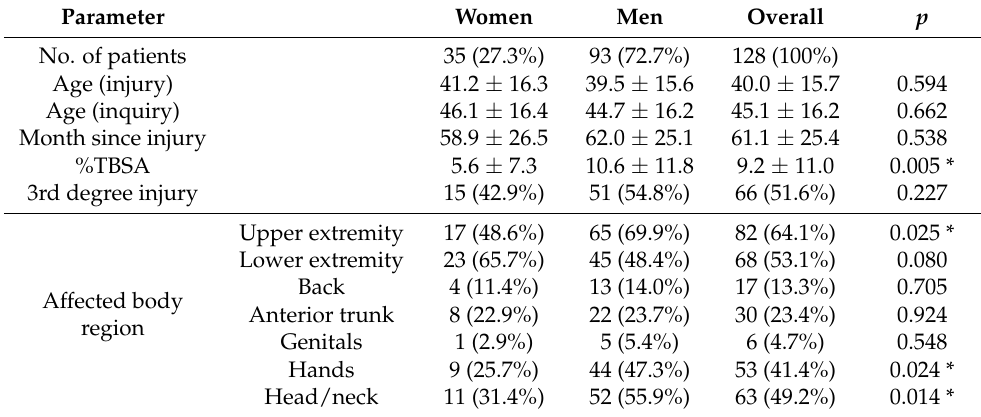
Table 1. Baseline parameters. * =